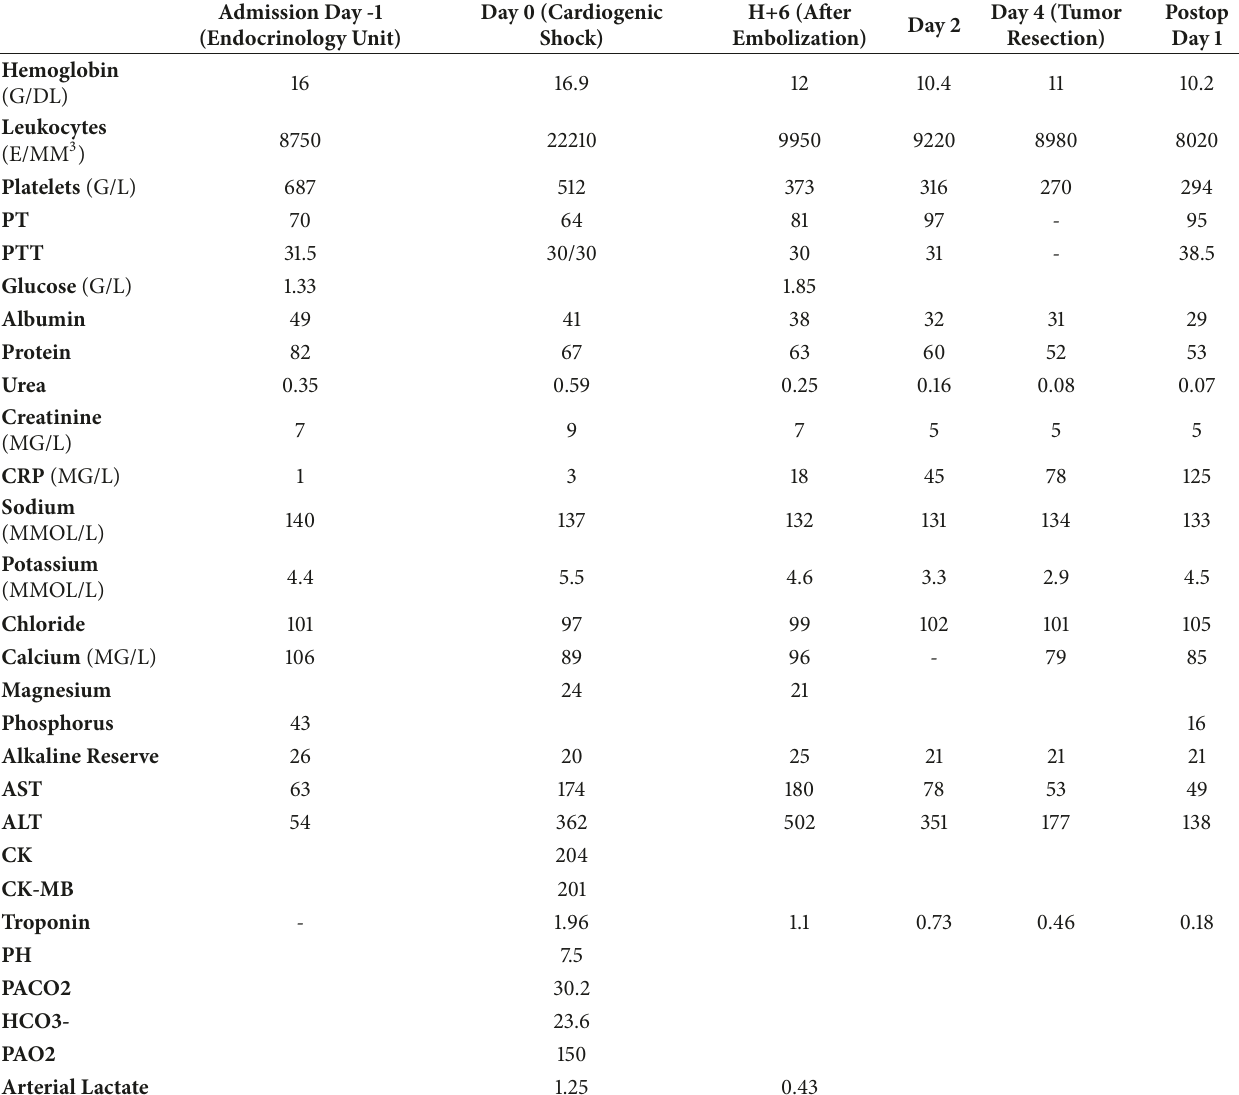
Table 1: The patient’s lab work-up evolution during the hospital